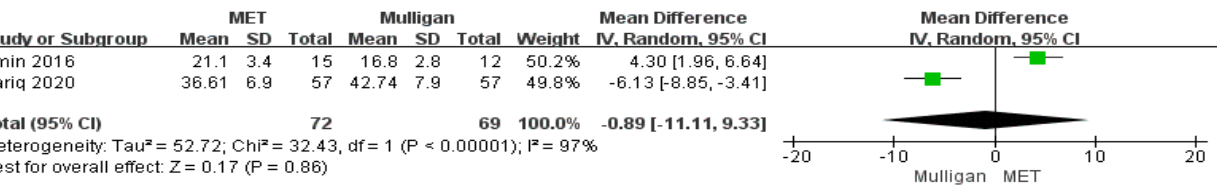
Figure 5. Meta-analysis of active knee extension (AKE) outcomes compared between muscle energy technique (MET) and the Mulligan technique groups [36,39]. SD: standard deviation; CI: confidence interval.